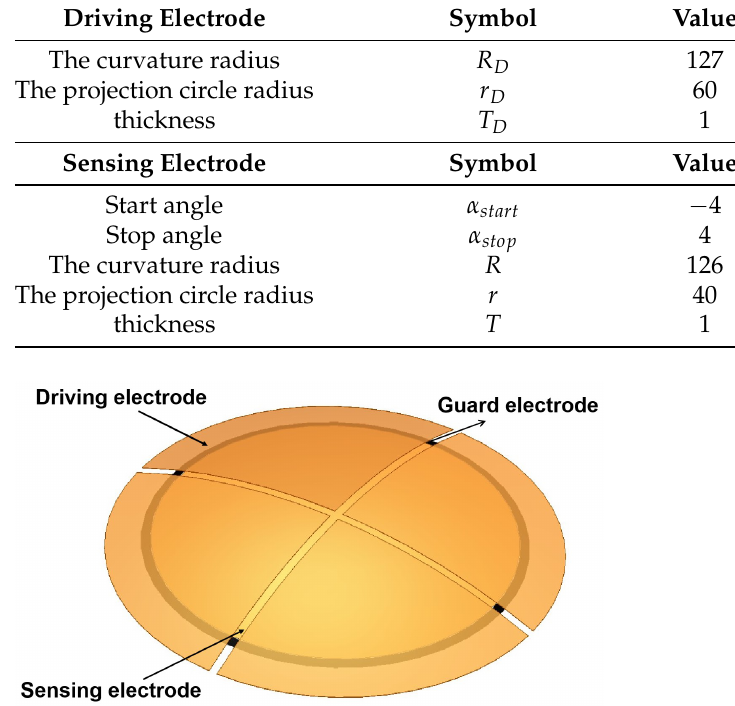
Figure 3. Model of the capacitive